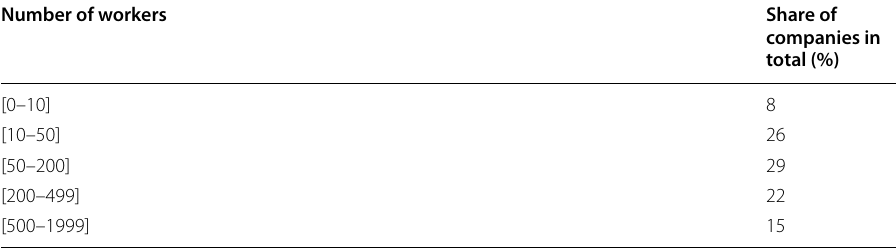
Sources: Opcalia TMC. Opcalia is an association which collected contribution of companies for training in different professional branches including textile